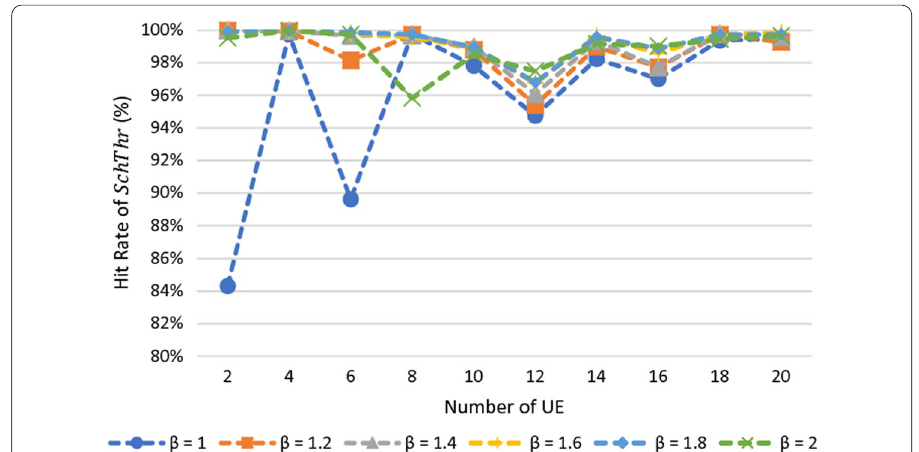
Fig. 9 Hit rate of Sch Thr larger than Buffer UE_Data ; Estimating the experimental hit rate results for different values